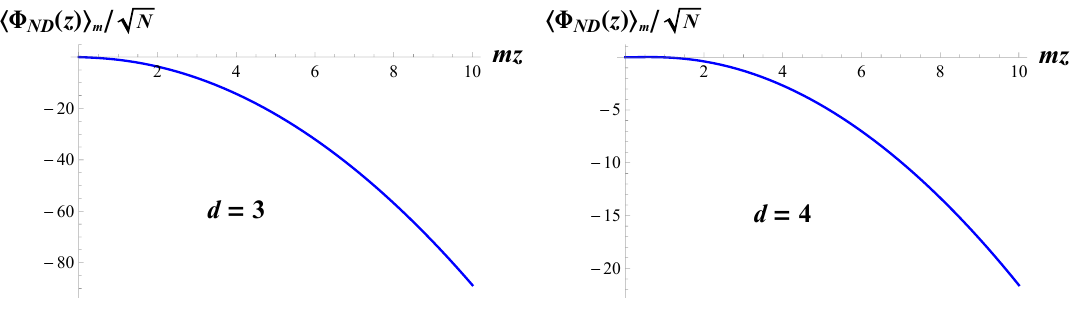
Figure 3 . The VEV of the non-decaying scalar bulk field in the presence of a finite mass m deformation as a function of mz , where z is the radial direction, for d = 3 (left) and d = 4 (right).